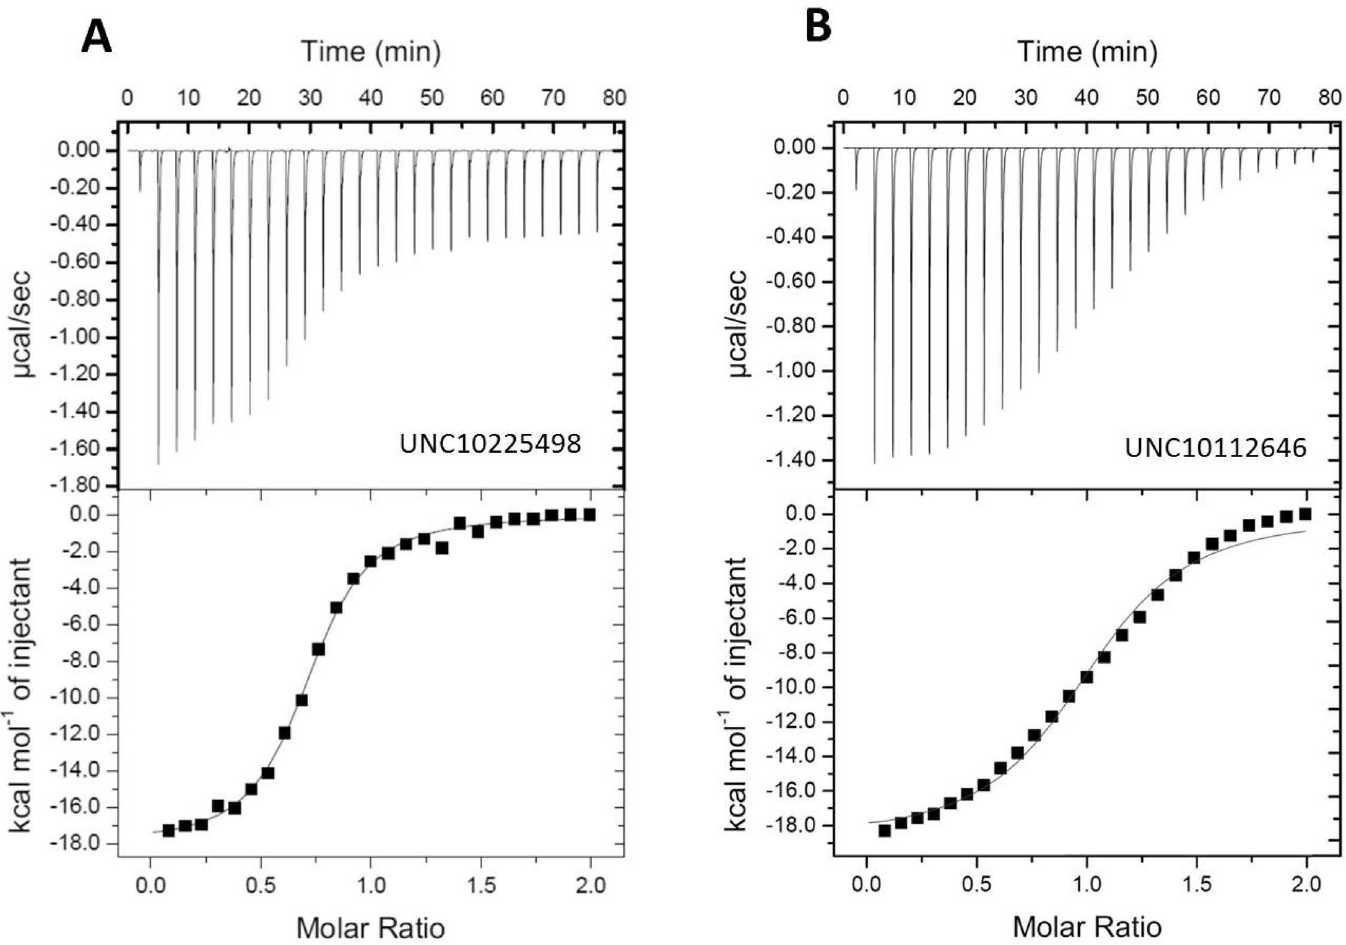
Fig 5. Analysis by ITC of the interaction of UNC10225498and UNC10112646with PPIP5K The upper panels show the raw data for heat output from the ligand/protein titrations; the lower panels show the least squares fitting of the titration data assuming a single site binding model.